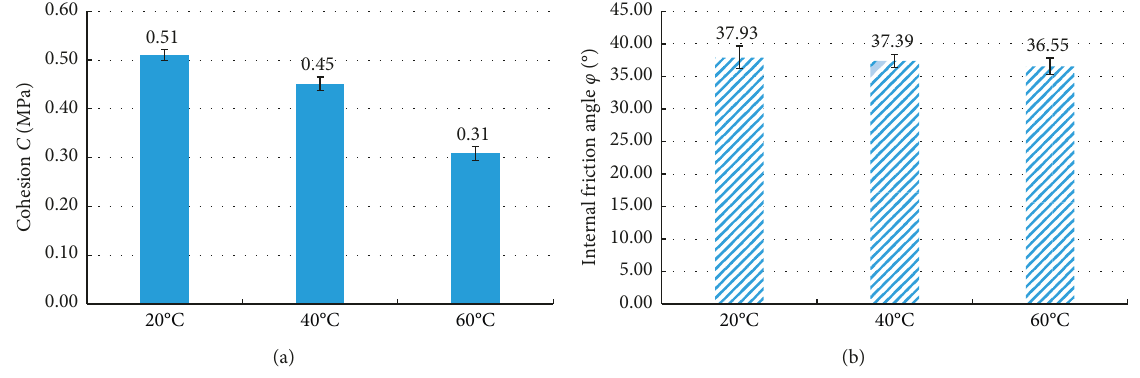
Figure 14: Test results of (a) C and (b) φ at different temperatures.